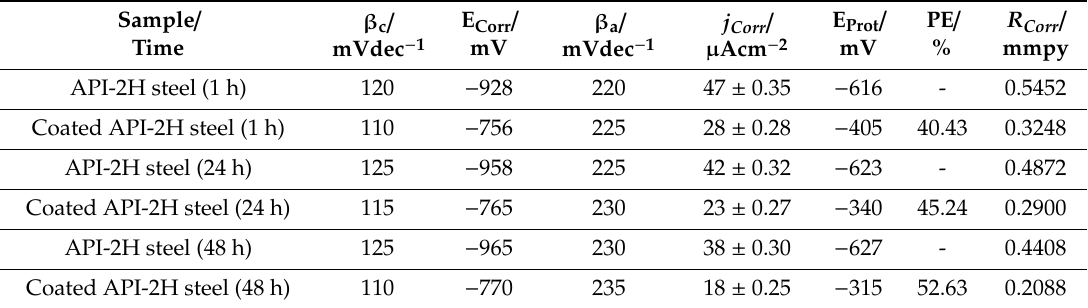
Figure 3. PCP curves of ( 1 ) API-2H steel and ( 2 ) 75% Cr 3 C 2 − 25%NiCr coated API-2H steel after exposure in 4% NaCl solution for 48 h. exposure in 4% NaCl solution for 48 h. Table 1. Cyclic potentiodynamic polarization (PCP) data obtained for the API-2H steel and